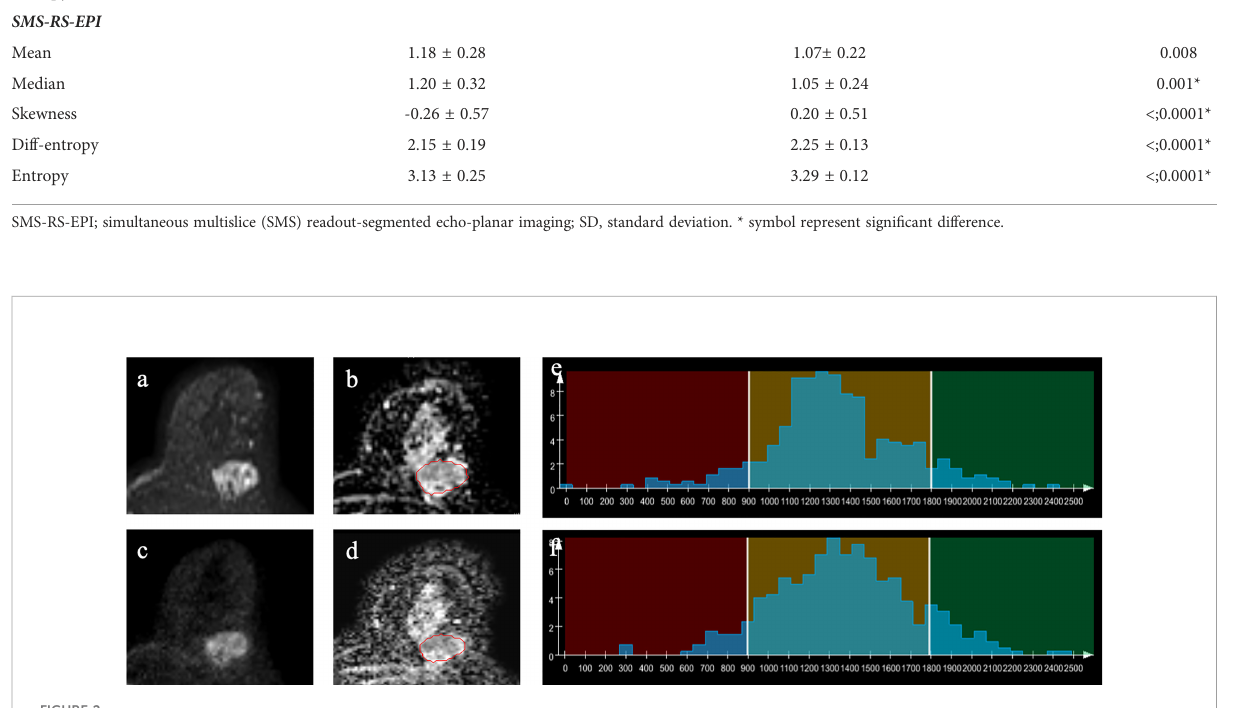
FIGURE 2 Example images of a 60-year-old woman with invasive ductal carcinoma in the left breast (A – D) . A-ZOOMit image of b 1,000 (A) ; apparent diffusion coef fi cient (ADC) map based on A-ZOOMit (B) ; SMS-RS-EPI image of b 1,000 (C) ; ADC map based on SMS-RS-EPI (D) ; histogram of segmented tumors based on ADC maps (E, F)